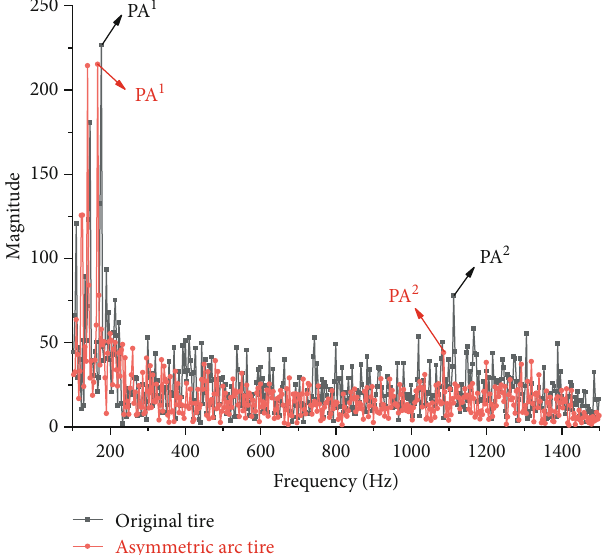
Figure 16: The spectrum comparison between the asymmetrical arc tire and the symmetric